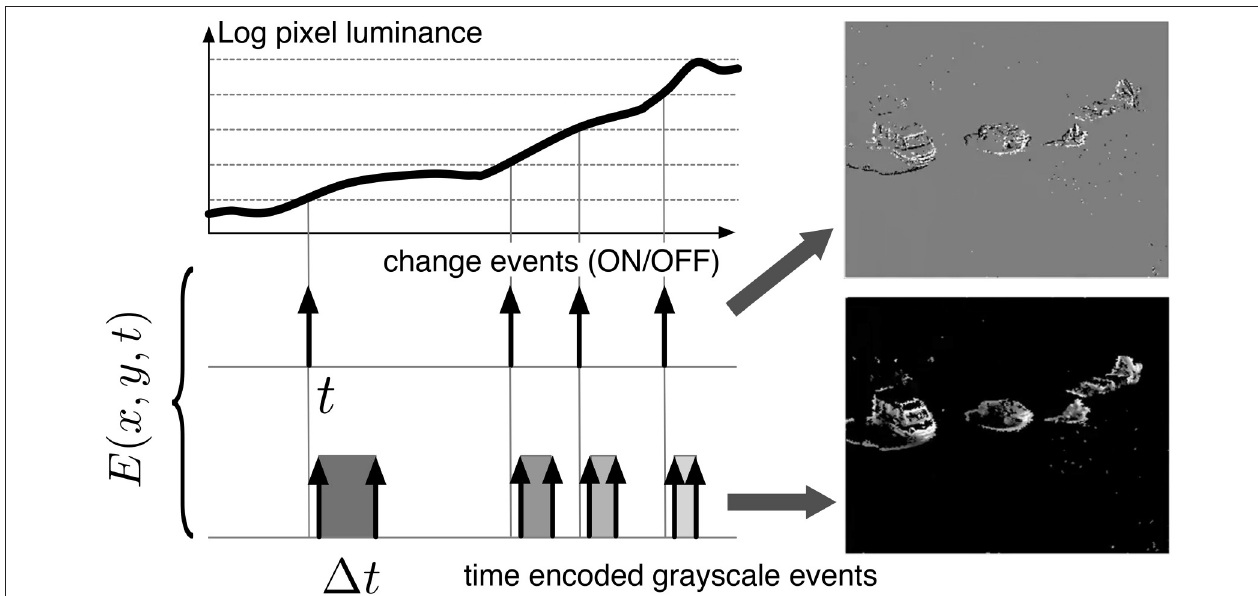
FIGURE 1 | Functional diagram of the event-based acquisition sensor used in this work. Two types of asynchronous events, encoding change and brightness information, are generated and transmitted individually by each pixel of the imaging array. 1 t is the time difference between the crossing of two thresholds and is inversely proportional to the pixel luminosity. Top right: Change events accumulated over a few milli seconds. Pixels that transmitted an ON event are represented in white, those that transmitted an OFF event are represented in black. The gray background represents pixels for which the luminosity has not changed over the selected time frame. Bottom right: Gray levels are proportional to the inverse of the time difference between two successive events emitted by the exposure detector. Pixels for which the luminosity has not changed over the selected time frame are represented in